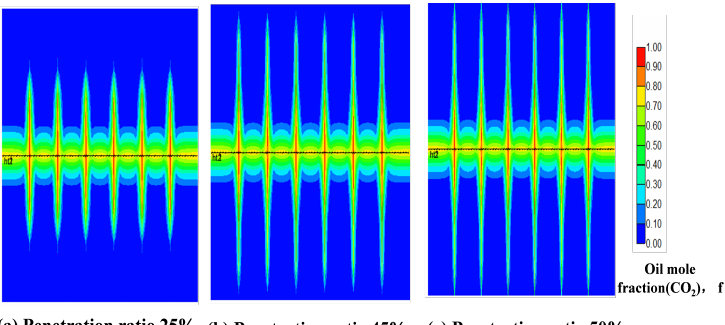
Figure 7. Schematic diagram of the crack action range with different penetration ratios, ( a ) The penetration ratio is 25% ( b ) The penetration ratio is 45% ( c ) The penetration ratio is